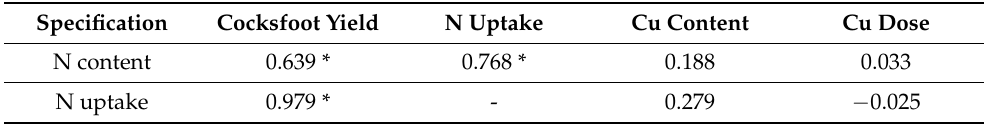
Table 5. Linear correlation coefficients between selected properties of cocksfoot.